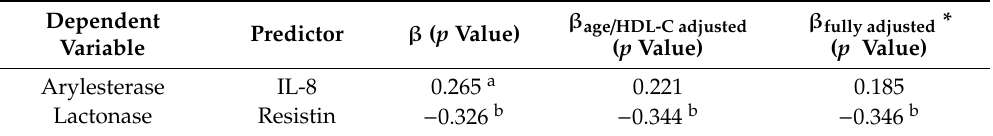
Table 3. Multiple regression analysis of the relationship between PON1-arylesterase and IL-8 and between PON1-lactonase activity and